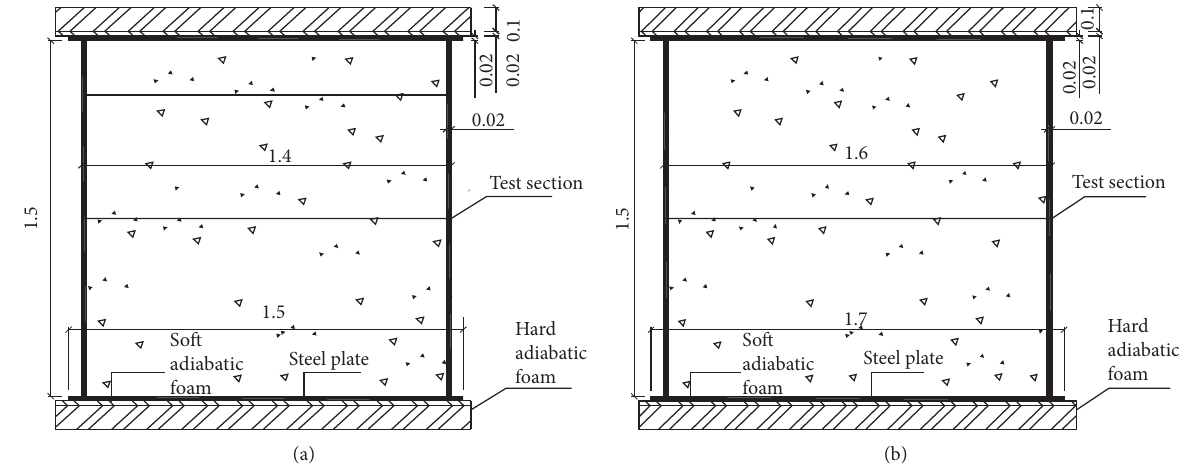
Figure 1: Dimensions of the CFST members evaluated in this study (m). (a) 1.4m diameter. (b) 1.6m diameter.